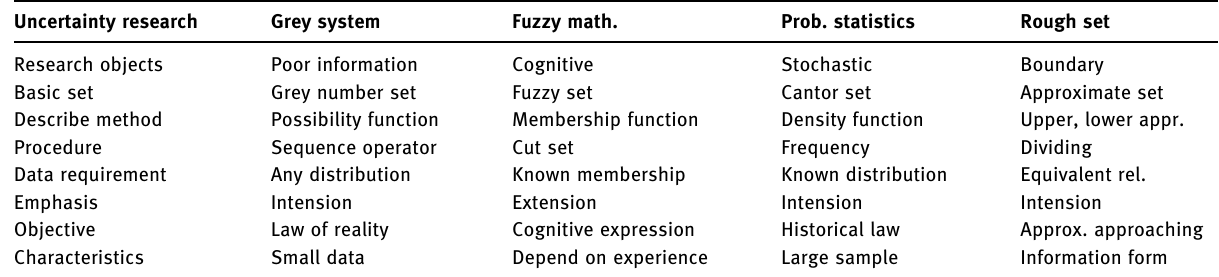
Table 1: A comparison of grey system with other di ff erent uncertainty approaches [ 35,36 ] Uncertainty research Grey